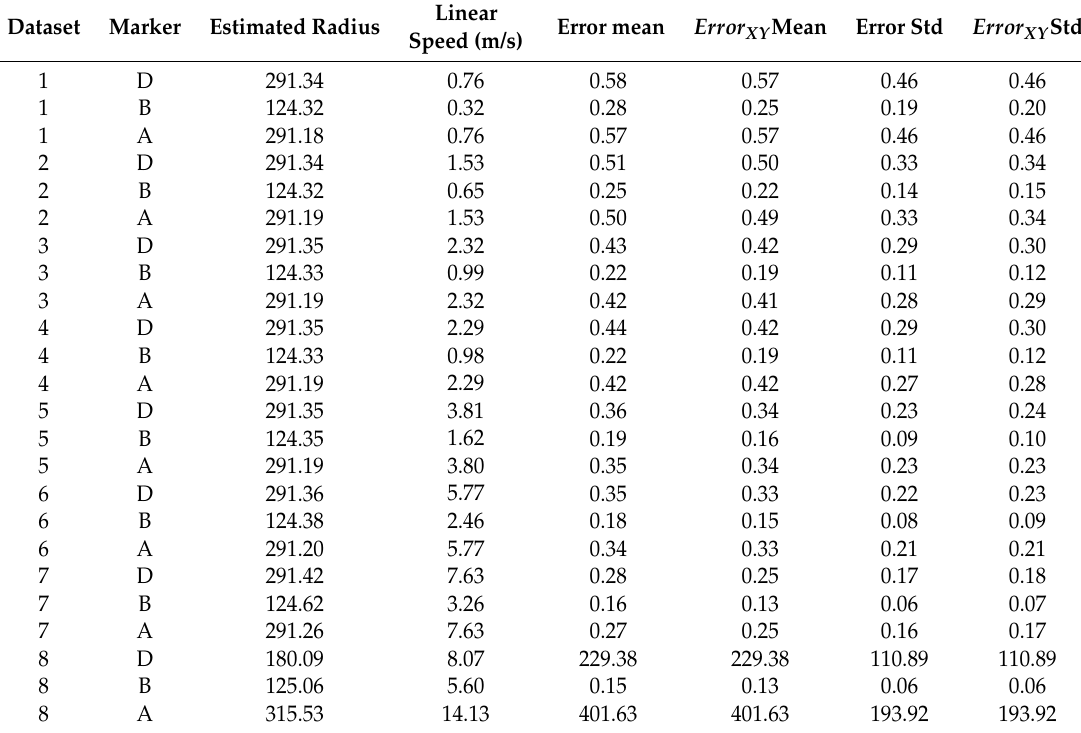
Table 7. Dynamic experimentation results in millimeter. 3D error and in-plane error ( Error XY ). Dataset 8, markers A and B are not workable. Due to high speed, the centrifugal force unstuck markers.